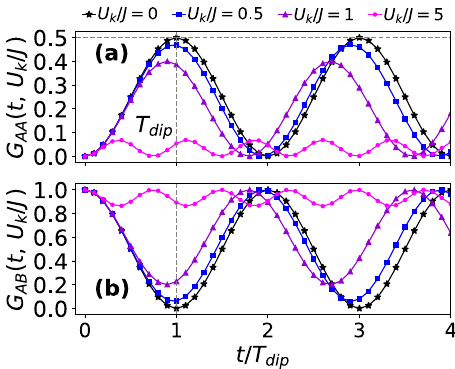
Fig. 4 Correlation functions of elementary QPIC. Behaviors of a the auto- correlation G AA ( t , U k / J ) and b the cross-correlation G AB ( t , U k / J ) as a function of the time spent within the hopping region of length l , and for different values of the ratio U k / J . This time, t , is given in units of T dip = π /(4 J ). The vertical dashed lines at t / T dip = 1 identify the occurrence of the Hong-Ou-Mandel effect for U k / J = 0. At such condition (as well as for t / T dip = 2 n + 1, with n being an integer, see Eq. (10)), the linear QPIC behaves as a 50:50 beam-splitter. As a consequence, the auto- and cross- correlation functions are at maximum and minimum values,